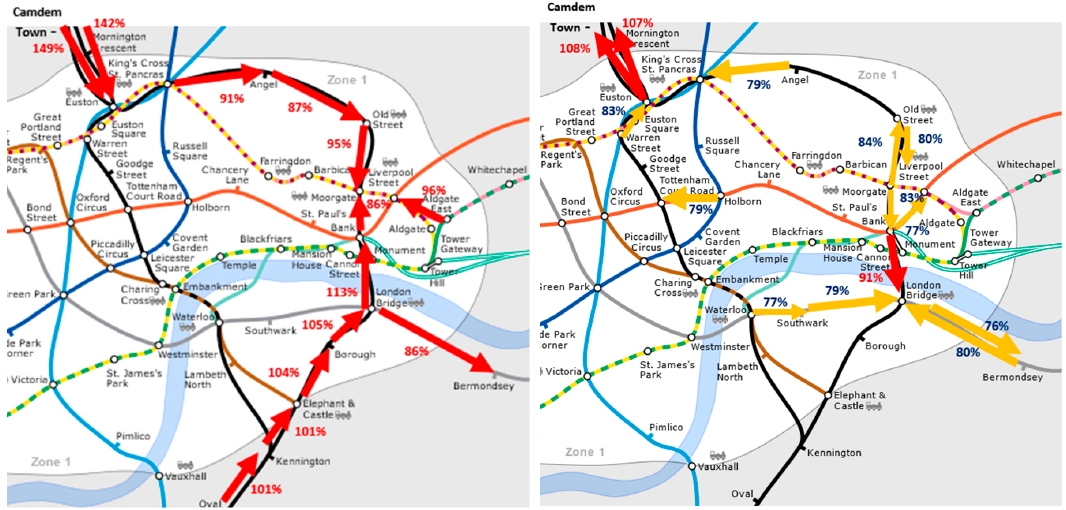
Figure 14. Map of Central London showing the highest occupancy rate of LU stations links at 8:30–8:45 AM ( left ) and 5:30–5:45 PM ( right ). Those links with 85% or higher occupancy rates are in red.